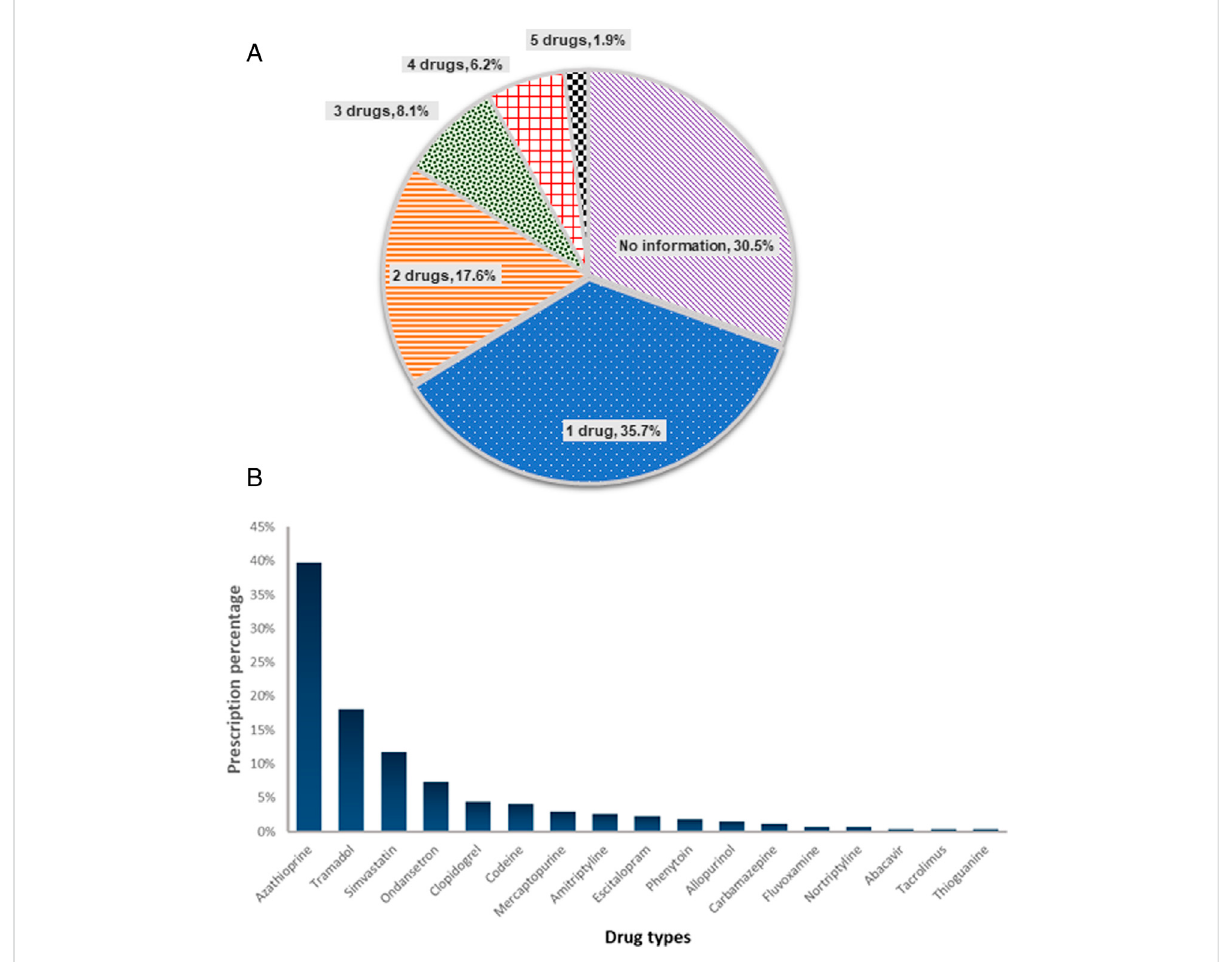
FIGURE 3 Potential of PGx multi-gene testing (A) Number of concurrent medications with PGx guidance being ordered per patient (N = 210) (B) Prescription pattern of actionable drugs in this patient cohort (N = 210). Actionable drugs refer to drugs with CPIC level 1A guidelines, and can be tested